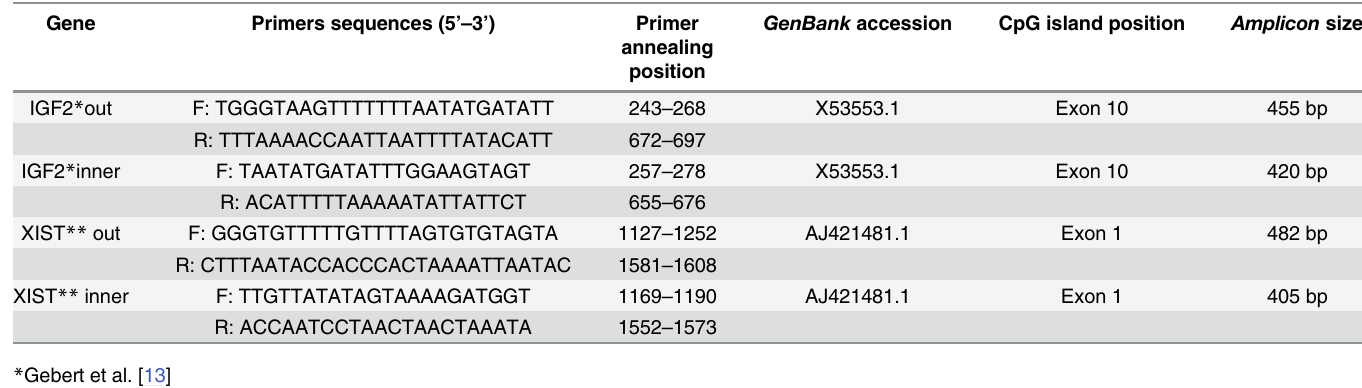
Table 1. Gene identification, primer sequence and annealing position, GenBank accession number, CpG island position and amplicon size. Gene Primers sequences (5 ’– 3 ’